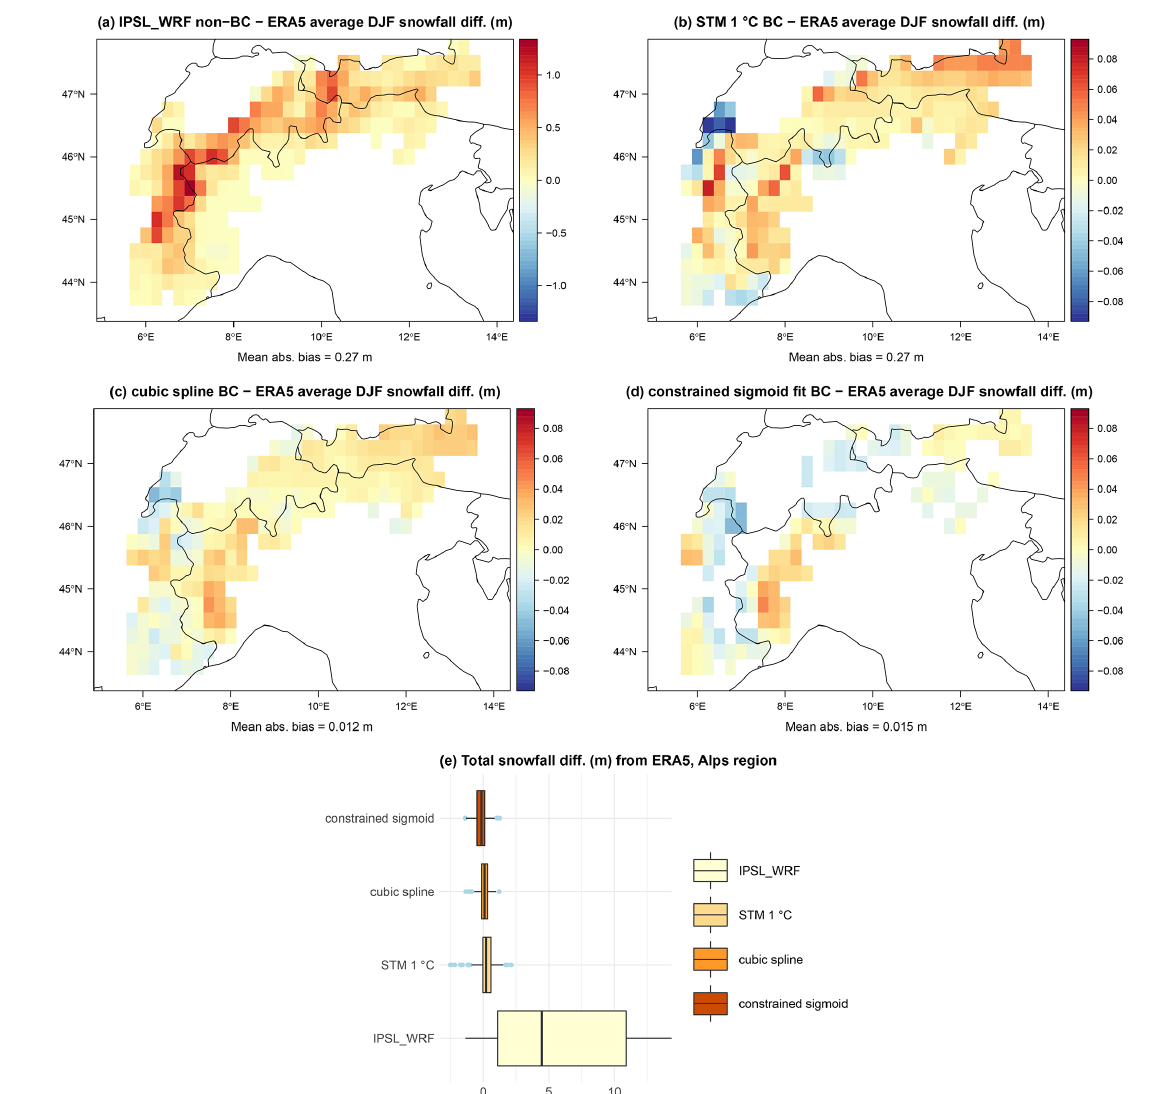
Figure 10. Maps of average 1979–2005 DJF snow differences over the Alps region between raw IPSL_WRF (a) , STM (b) , cubic spline regression (c) , sigmoid fit (d) bias correction, and ERA5. Corresponding summary box plots are shown in panel (e)